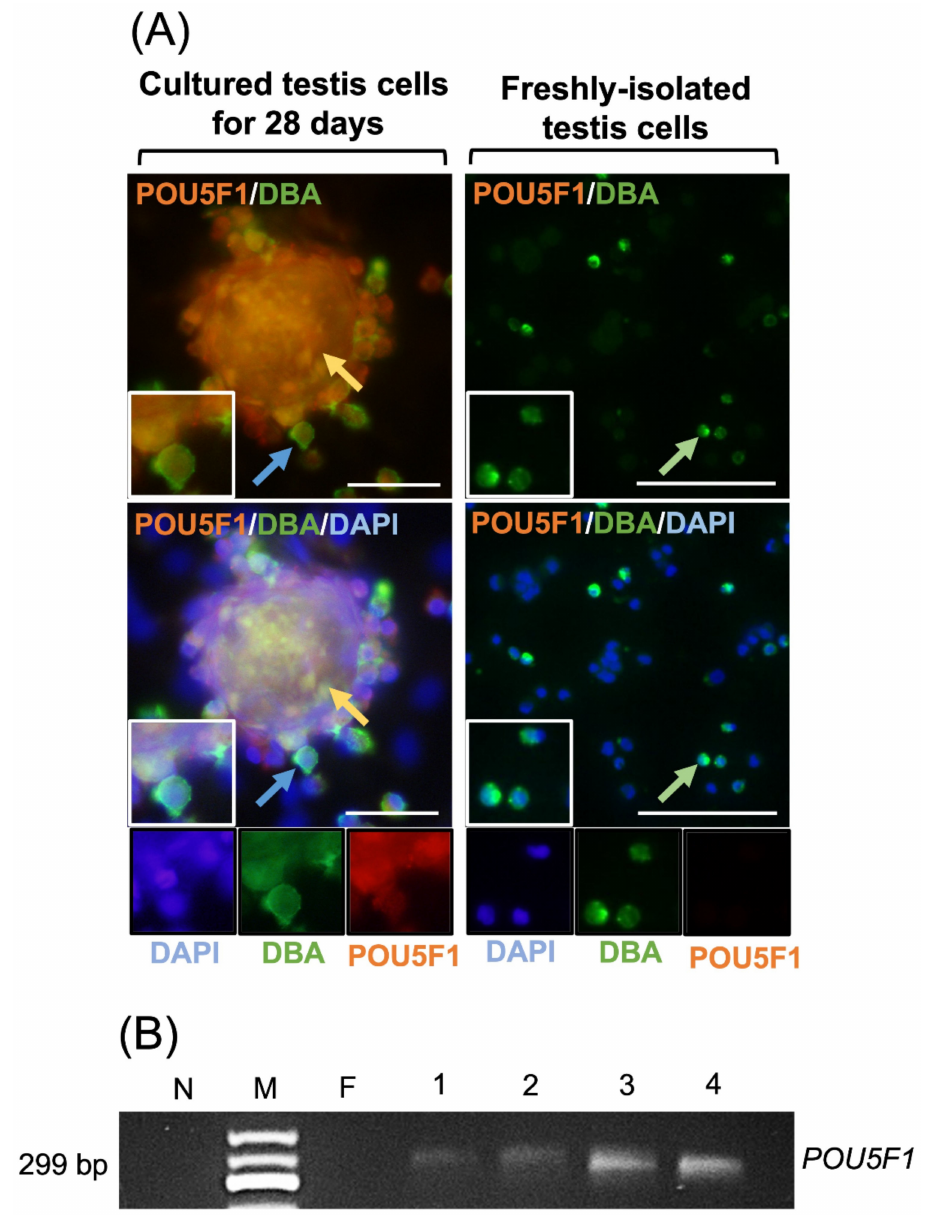
Figure 4. Evaluation of POU5F1 expression as a pluripotency marker and DBA as a gonocyte-specific marker by freshly-isolated and cultured porcine testis cells in regular media. Following isolation of testis cells, gonocytes were positive for DBA (green arrows) but negative for POU5F1. When cultured in regular media, gonocytes (blue arrows) and EBLCs (yellow arrows) were positive for both POU5F1 and DBA ( A ). Testis cells were also negative for POU5F1 immediately after isolation in RT-PCR analyses, while they were positive in samples of cultured cells on days 7, 14, 21, and 28 ( B ). These findings are indicative of spontaneous reversion of MGSCs into more primitive developmental stages. N, no template control; M, 50 bp DNA ladder; F, freshly-isolated testis cell sample; Lines 1–4, cultured cells and colonies in regular media on days 7, 14, 21, or 28, respectively. Insets display higher magnifications (Scale bar = 50 µ